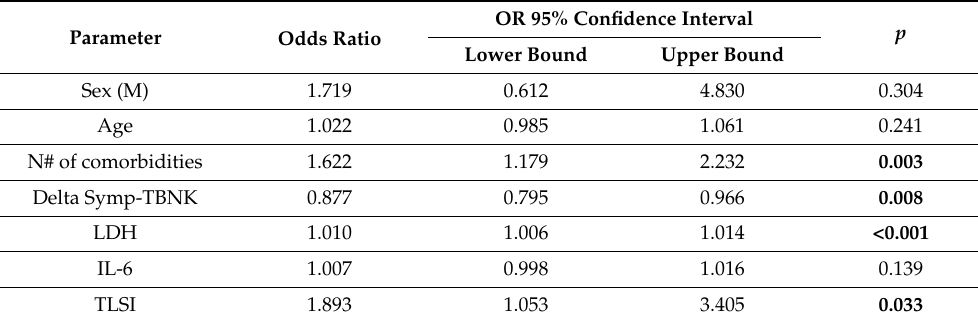
Table 4. Multivariable logistic regression analysis for in-hospital 30-day mortality in patients with SARS-CoV-2